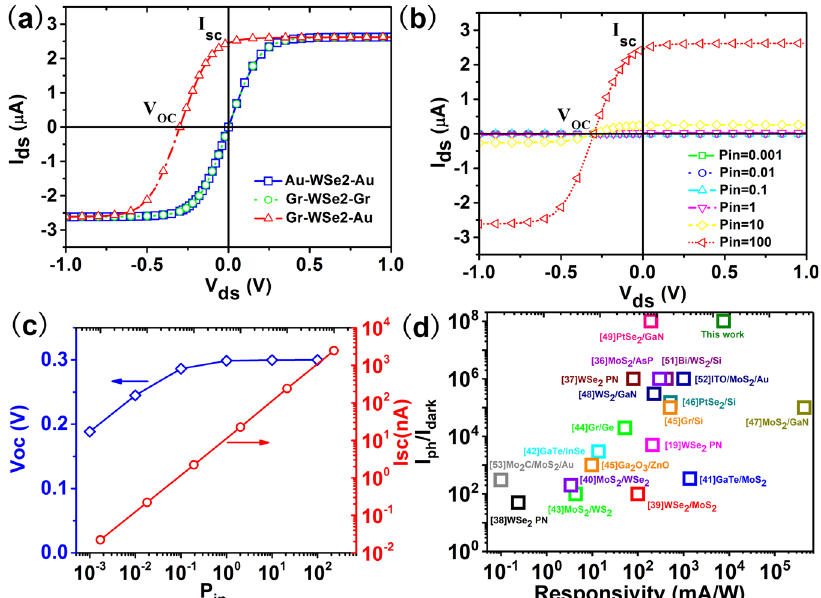
Fig. 6 Theoretical analysis and performance comparison of the self-driven photodetector. a Simulated I – V curves of three MSM photodetectors with different electrode con fi gurations. b Simulated I – V curves of the Gr – WSe 2 – Au photodetector under various light power densities. c Dependence of V oc and I sc on the light power density. d Comparison of the performances of self-driven photodetectors based on different materials and working